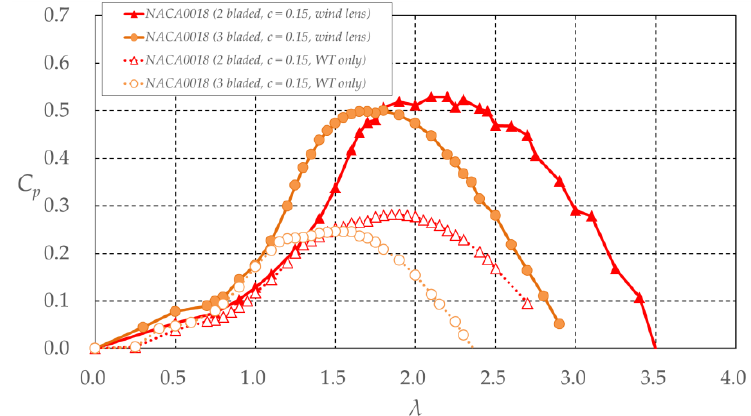
Figure 13. Comparison of power coefficient C p of two- and three-bladed wind turbines with and without a wind lens vs. tip speed ratio λ (wind lens: L = 1.14D m, h = 0.5D m, φ = 15°). Refer to Figure 2 for L , D , h , and φ.